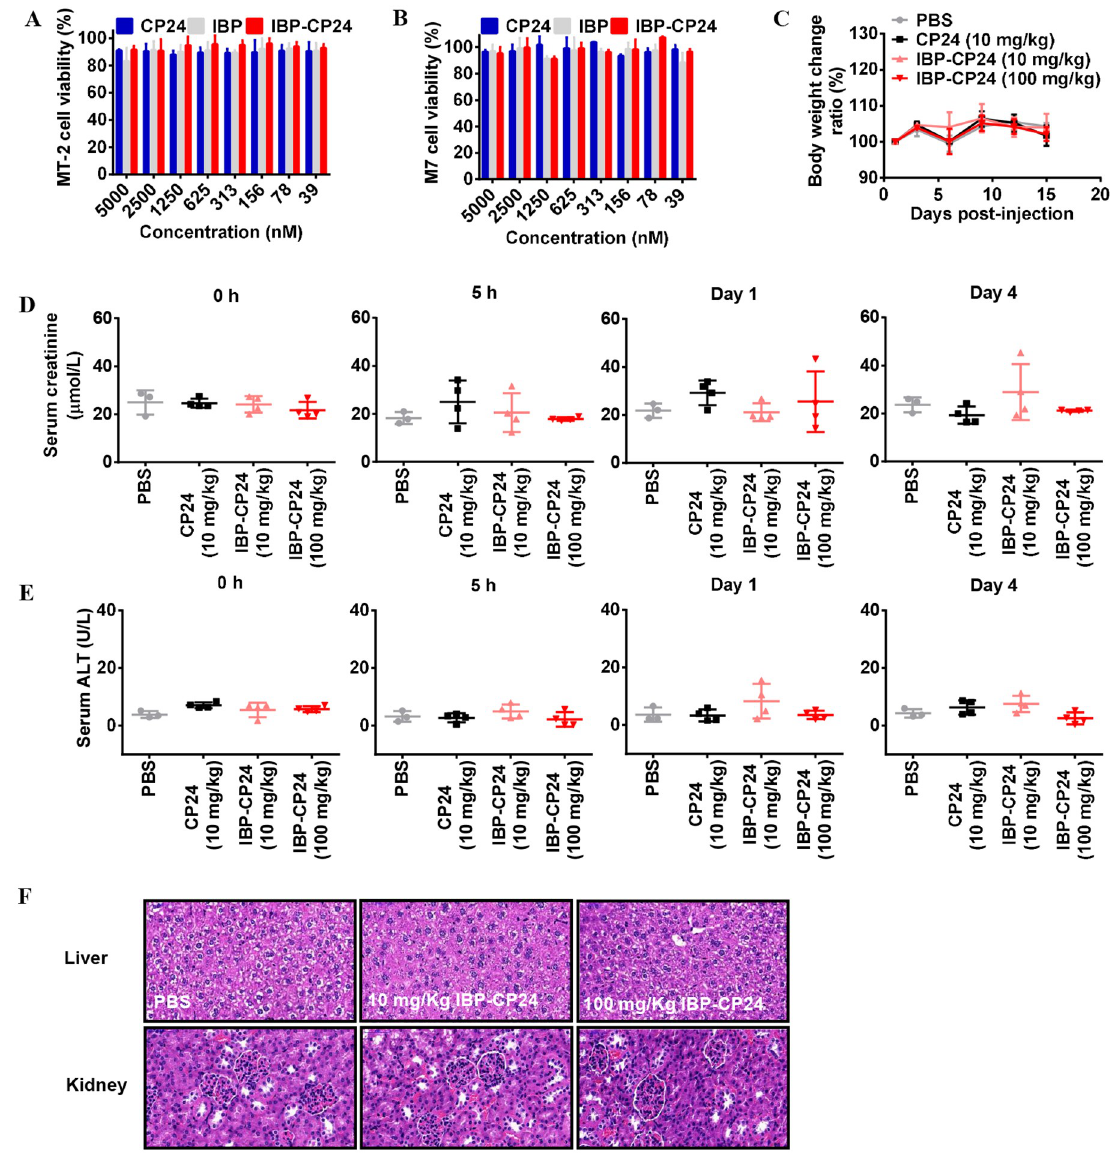
Fig 4. Evaluation of in vitro and in vivo toxicity of IBP-CP24. (A and B) Cytotoxicity of CP24, IBP and IBP-CP24 to MT-2 (A) and M7 (B) cells. Each sample was tested in triplicate and the data are presented as mean ± SD. (C) Body weight changes were recorded at the indicated time points in mice treated with PBS, 10 mg/kg CP24, 10 mg/kg IBP-CP24 or 100 mg/kg IBP-CP24. Each time point is represented by mean ± SD. (D) The creatinine in mice sera was measured by using a creatinine assay kit at different time points. Error bars indicate standard deviations. (E) ALT activity in the sera of mice was measured with an ALT assay kit. Error bars indicate standard deviations. (F) H&E staining analysis of livers and kidneys in treated mice at day 15 post-injection.